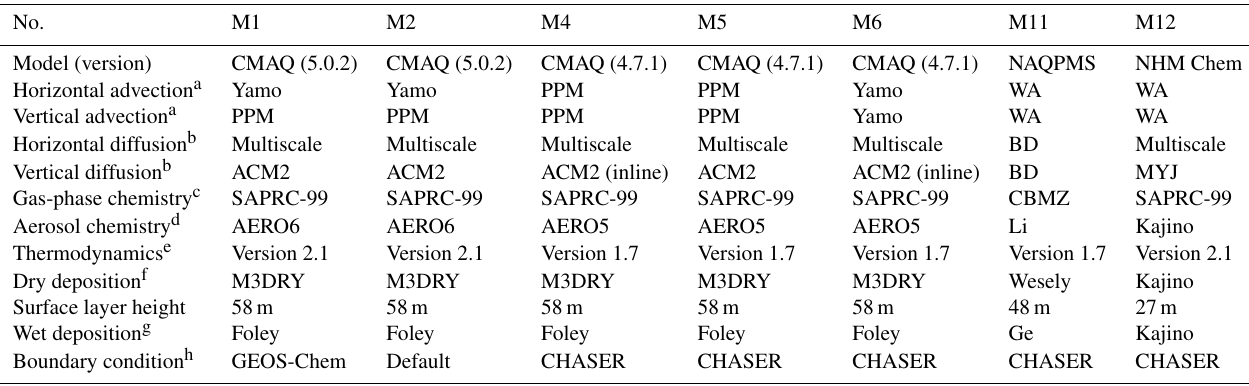
Table 1. Descriptions of the models used in this acid deposition study.